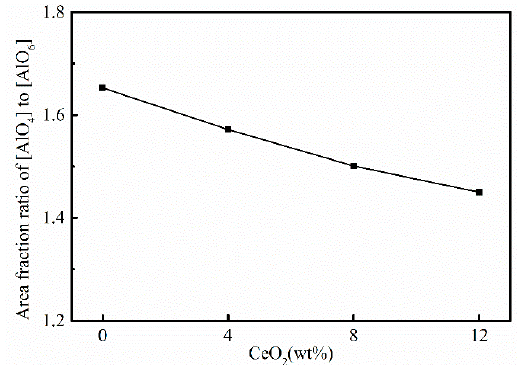
Figure 9. The area ratio of [AlO 4 ] to [AlO 6 ] in the mold fluxes with different CeO 2 contents.